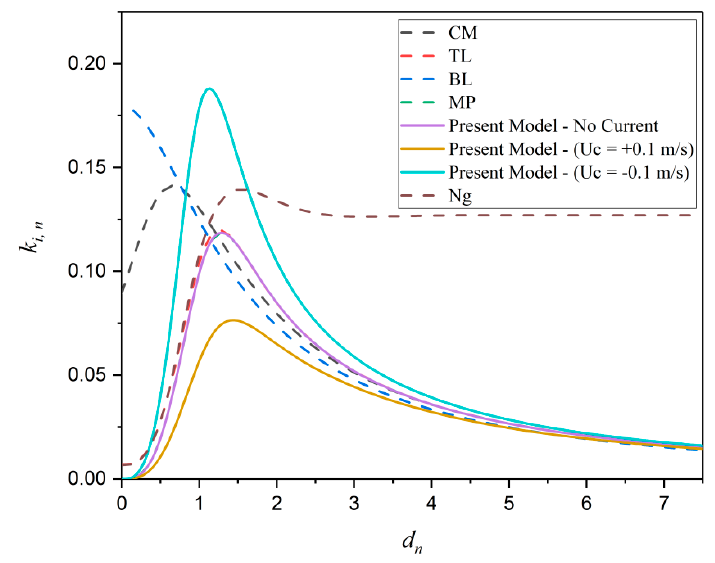
Figure 2. Dissipation rate versus mud dimensionless thickness.